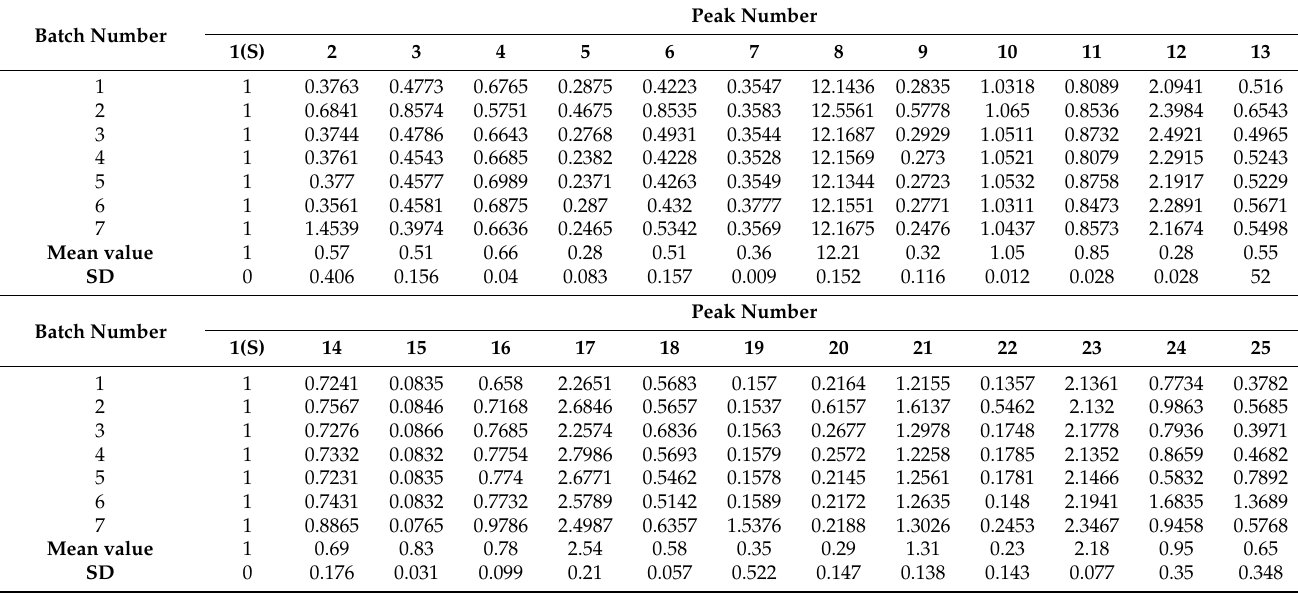
Table 3. Relative peak area of common peaks in seven batches of S. chamaejasme flowers